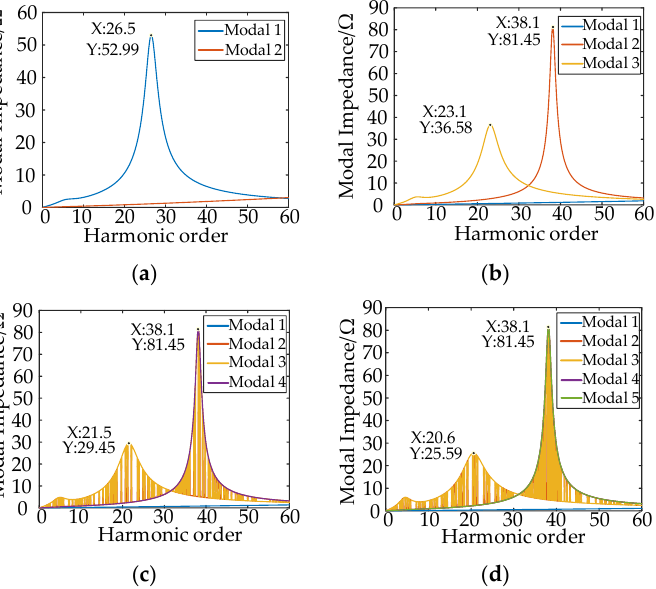
Figure 9. The modal impedance curve when n is changed: ( a ) n = 1; ( b ) n = 2; ( c ) n = 3; ( d ) n = 4.